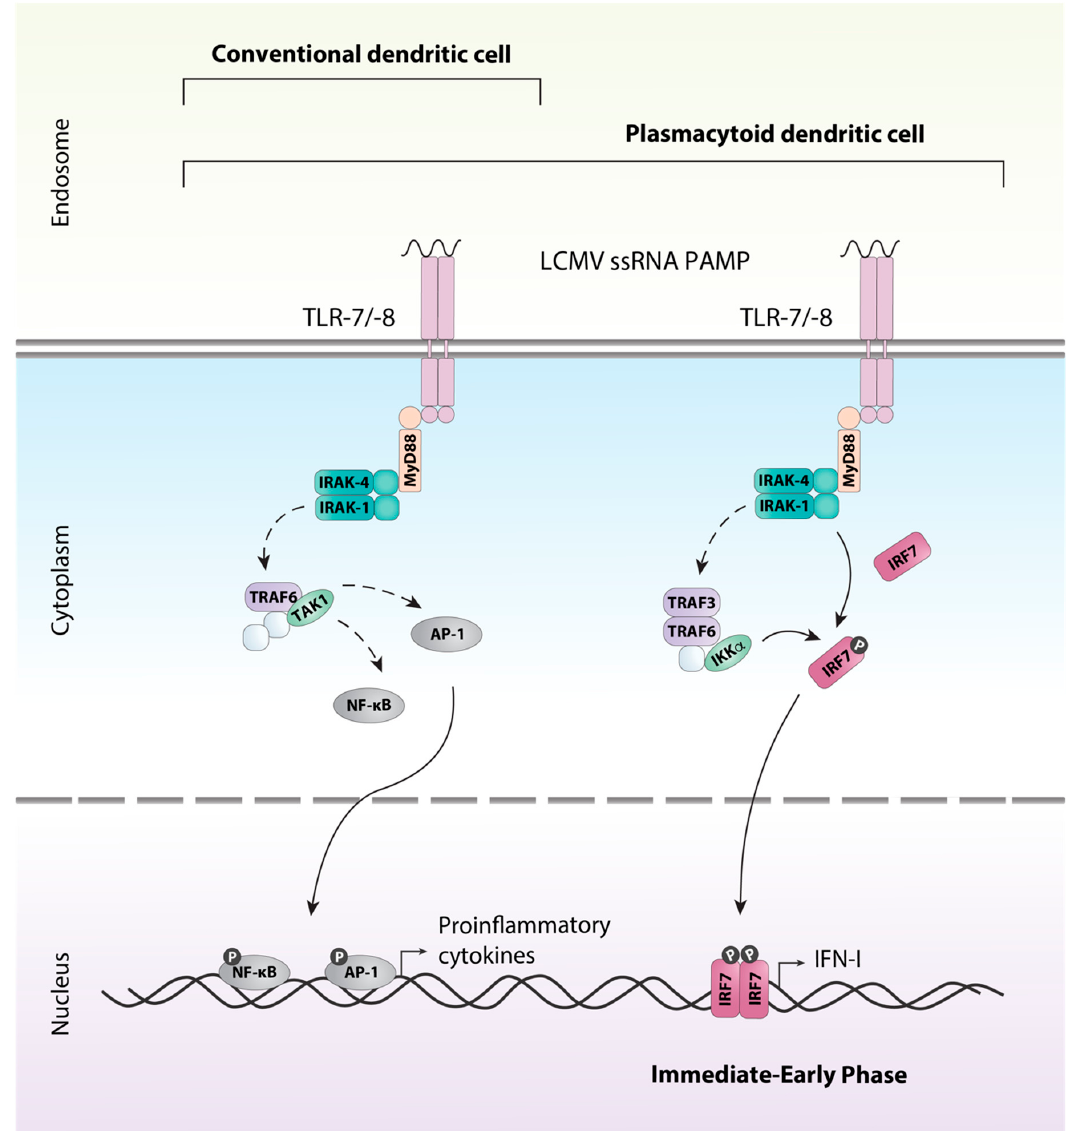
Figure 2. TLR-7/-8 signaling in dendritic cells. LCMV ssRNA is detected by the endosomal TLRs; TLR7 and TLR8, expressed by conventional dendritic cells (cDCs) and plasmacytoid dendritic cells (pDCs). The association of MyD88 with the receptor results in the association of IRAK1 and IRAK4 through the death domains. Once phosphorylated the IRAK proteins dissociate from the receptor to associate with TRAF6. TRAF6 interacts directly and indirectly with a number of other proteins, including protein kinases such as TAK1. TAK1 can then triggers the activation of transcription factors such as AP-1 via the MAPK pathway or NF- κ B through the canonical IKK complex. Upon their activation, the transcription factors translocate to the nucleus and induce production of inflammatory cytokines. In addition, pDCs utilize a unique pathway that allows for the rapid immediate-early production of type I interferons. Similar to above, MyD88 associates with the receptor and a complex including TRAF3, TRAF6, IRAK1, IRAK4 and IKK α is formed. IRAK1 and IKK α phosphorylate the transcription factor IRF7, resulting in its activation and subsequent production of type I interferon (IFN-I). Solid arrows indicate direct steps, dashed arrows indicate multiple steps/additional proteins involved.